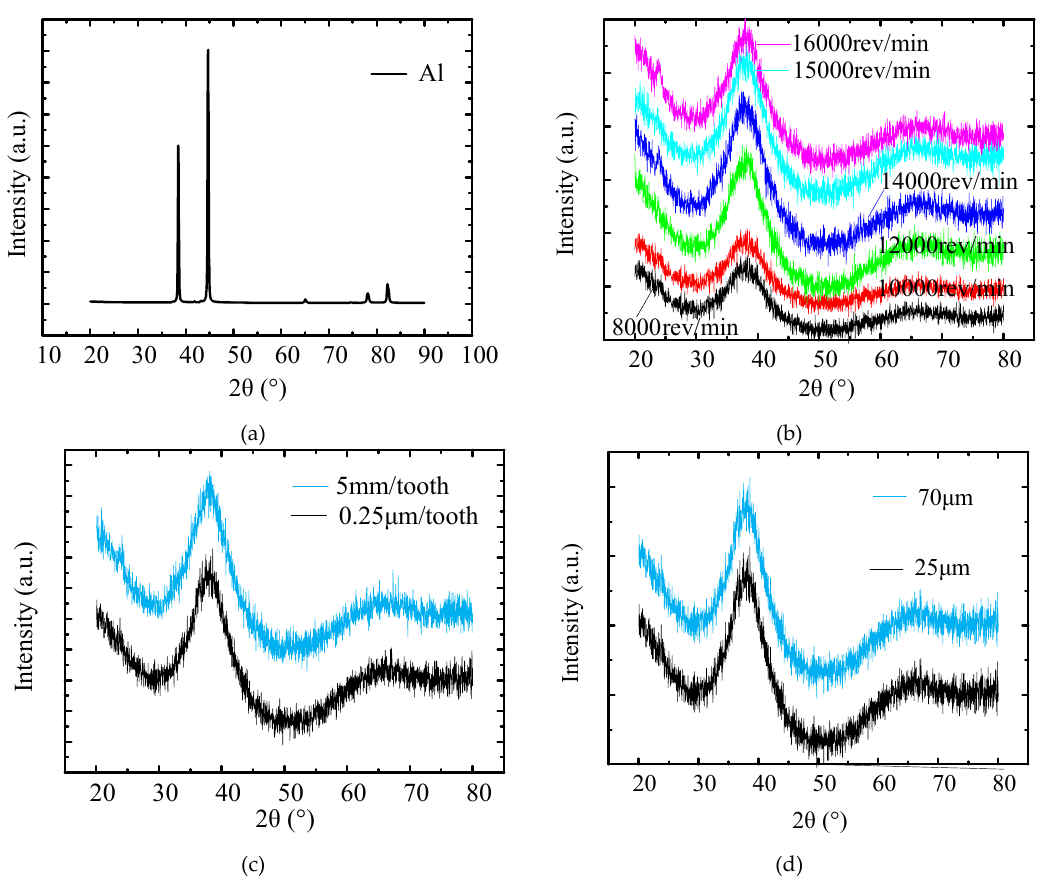
Figure 15. The influence of milling parameters on phase structure. ( a ) X-ray diffraction (XRD) result from a ZL101A workpiece; ( b ) XRD results under different rotation speeds; ( c ) XRD results under different feed rates; ( d ) XRD results under different depths of cut (DOCs).